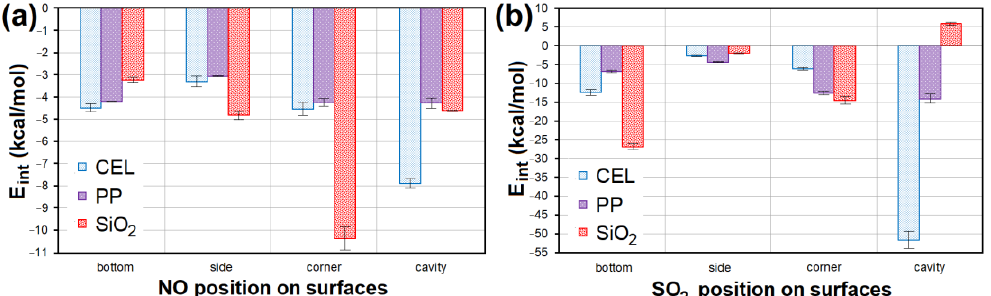
Figure 14. The E int comparison of models containing ( a ) NO and ( b ) SO 2 at different sites of CEL, PP and SiO 2 surfaces. CEL — cellulose, PP — polypropylene, SiO 2 — silicon dioxide, E int — interaction energy.